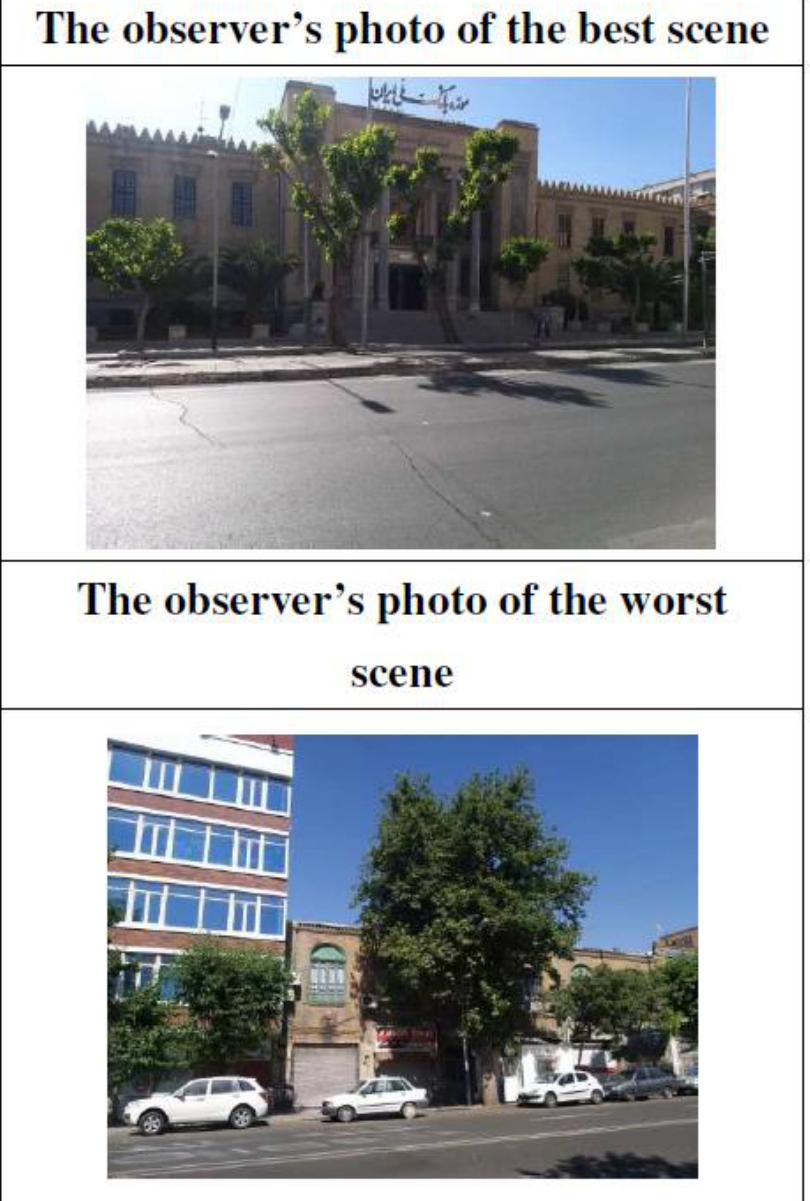
Figure 3. An example of the best and worst scene of urban facades photographed by an observer while moving for analysis using the VEP method (sample of Ferdowsi Street).